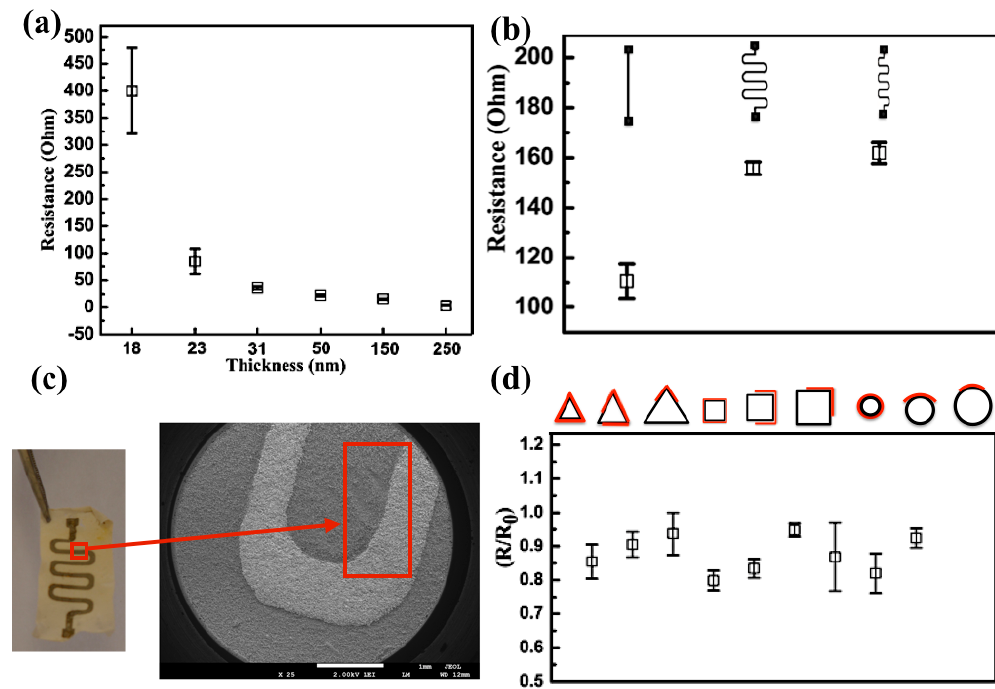
Figure 2. ( a ) Effect of the conductive silver pattern thickness on its electrical resistance, as measured by a multimeter. ( b ) Measurements of the electrical resistance of different patterns indicated the multiuse of the pattern structure on the surface of the electrospun substrate. ( c ) Optical image representation of the silver ‐ coated electrospun substrate with an enlarged micrograph showing the preservation of the microstructure after the RF sputtering process. ( d ) Schematic diagram of the silver pattern on the electrospun substrate wrapped around different curved surfaces with different angles (top) and the measurements of electrical resistance after cyclic load ( R ) to the initial value of electrical resistance ( R 0 ) of the silver pattern on the substrate versus the angle to which the substrate is turned (before degradation).